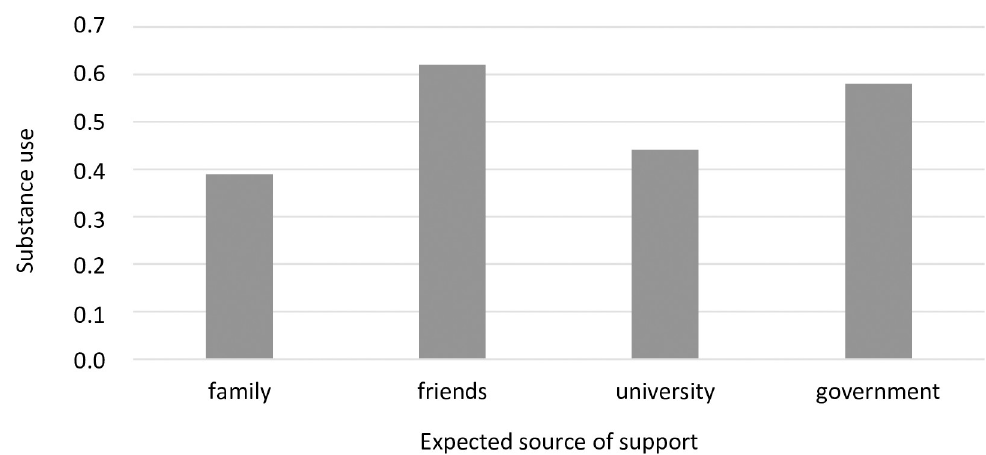
Fig 8. Students’ substance use (mean) and sources of expected support during the COVID-19 pandemic (F = 4.12 a , p = 0.007, η 2 = 0.02). � Welch’s correction was applied.